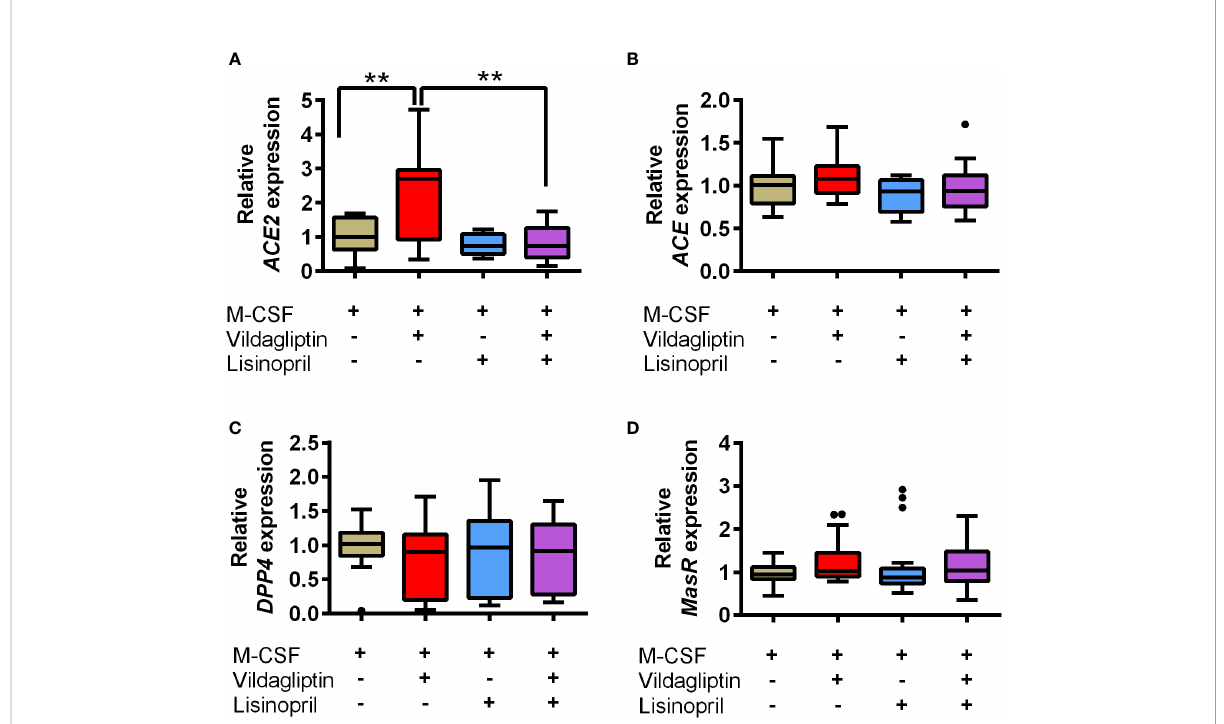
FIGURE 4 Effects of vildagliptin and lisinopril on the expression of RAS components and DPP4 enzymes in human monocytes/macrophages stimulated using M-CSF. Monocytes were isolated from hPBMCs using the MACS system and cultured for seven days with 50 ng/mL M-CSF in the presence or absence of each compound. The concentration of vildagliptin and lisinopril was 10 m mol/L, each. mRNA levels were assessed in three to six donors with three to six replicates per donor and were normalized using GAPDH as a reference. Data are relative to the M-CSF group at a concentration of 1. The effects of each compound on ACE2 (A) , ACE (B) , DPP4 (C) , and MasR (MAS1) (D) expression are shown. Boxes indicate the 25th and 75th percentiles; lines inside the boxes indicate medians, and whiskers indicate the upper and lower adjacent values (3/2- fold the interquartile range from the end of the box) as per Tukey ’ s test. Dots represent outliers beyond the whiskers ’ range ** p <